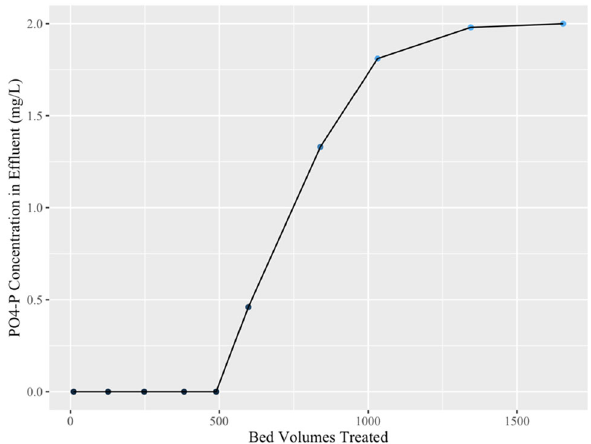
Fig. 1 Breakthrough curve of PO 4 -P concentration (mg/L) in the ef fl uent with respect to the number of bed volumes of synthetic wastewater treated. PO 4 -P concentration (mg/L) as a function of the number of bed volumes treated.